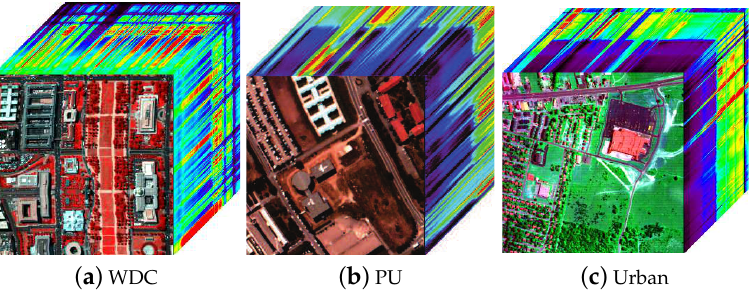
Figure 2. Falsecolor maps of the simulated and real HSI